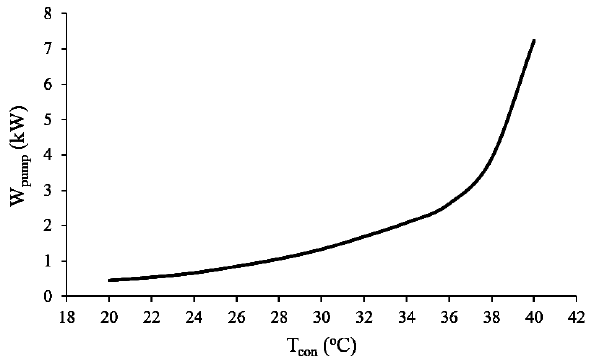
Figure 14. Effect of T con on pumping power.